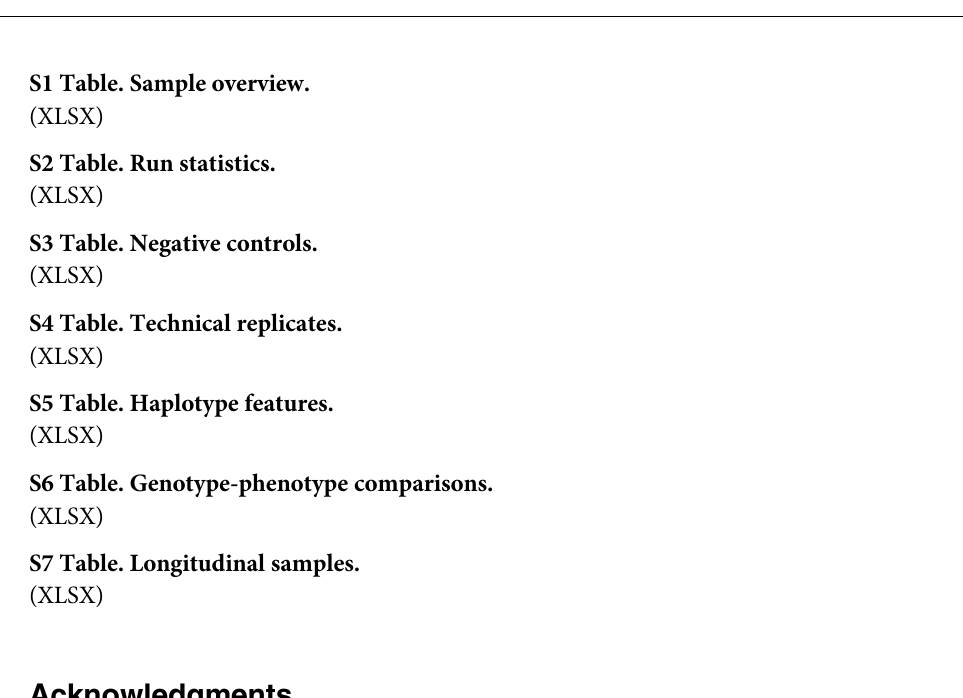
S1 Table. Sample overview. S2 Table. Run statistics. S3 Table. Negative controls. S4 Table. Technical replicates. S5 Table. Haplotype features. (XLSX) S6 Table. Genotype-phenotype comparisons. (XLSX) S7 Table. Longitudinal